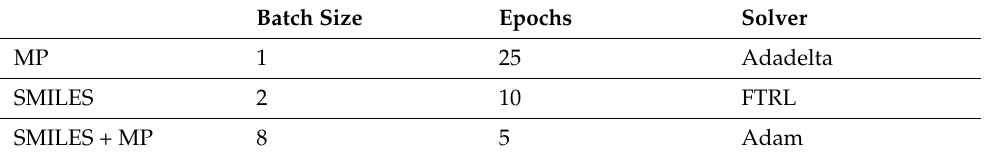
Table 3. Hyperparameters of the best-performing models for each of the observed input cases.